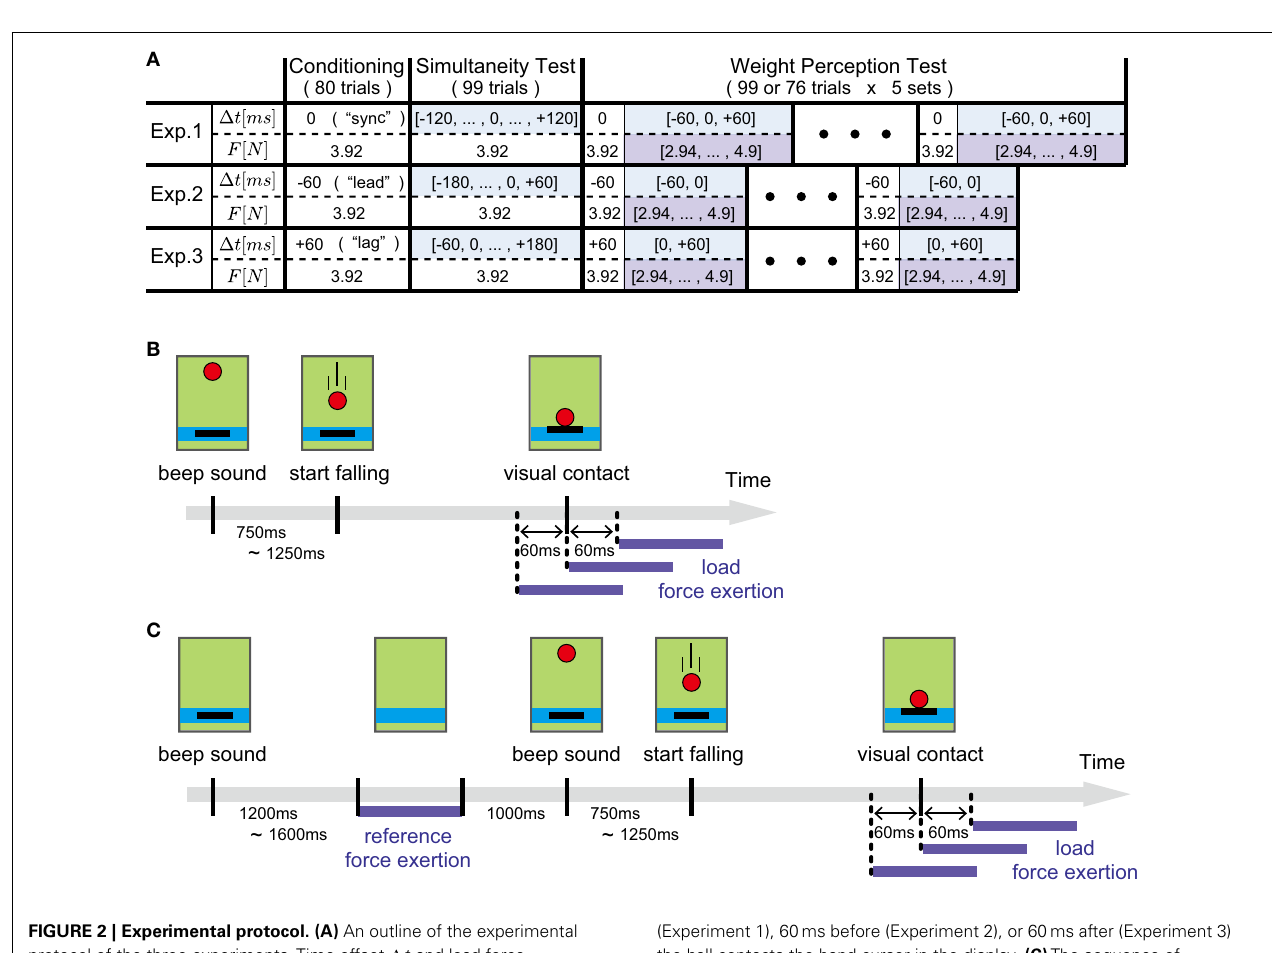
FIGURE 2 | Experimental protocol. (A) An outline of the experimental protocol of the three experiments.Time offset (cid:49) t and load force magnitude F in each trial are shown for the three sessions, i.e., conditioning, simultaneity test, and weight perception test sessions. (cid:49) t and F shown with color backgrounds indicate that they are chosen randomly in each trial.The details of their values are list in Tables 1 and 2 . (B) The sequence of events in a single ball-catching trial during the Conditioning session.The load force is applied at the same time